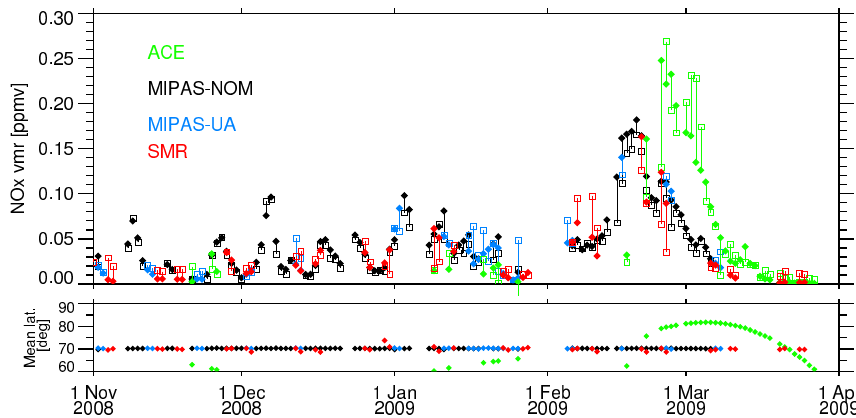
Figure 1. Upper panel: daily averaged NO x mixing ratios from satellite observations (open squares) at 0.022hPa within 60–90 ◦ N (black is MIPAS-NOM, blue is MIPAS-UA, red is SMR/Odin, green is ACE-FTS) and those of the upper boundary condition (filled diamonds) sampled at the respective observations’ time and location. Lower panel: mean latitude averaged over all observations of the individual instruments within 60–90 ◦ N. All averages are area-weighted.